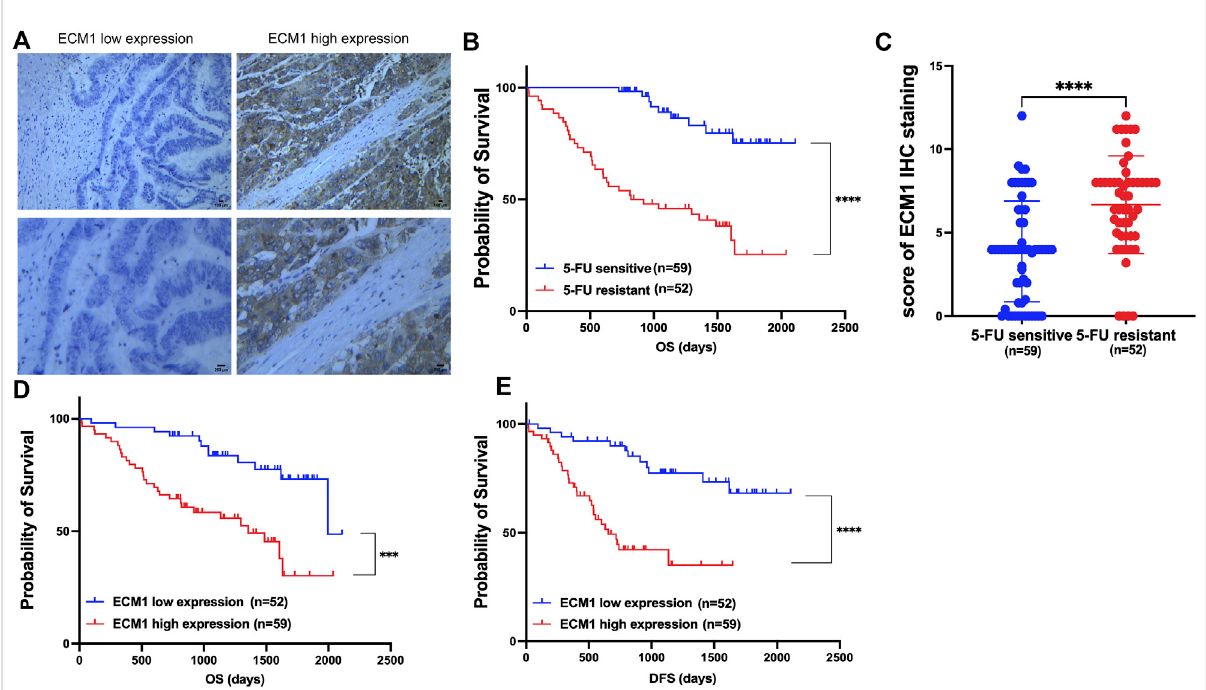
FIGURE 1 ECM1isassociatedwith5-FUresistanceandpoorprognosisinCRCpatients. (A) PhotographsillustratingthepresenceofECM1proteinintumor tissue samples from CRC patients. (B) Kaplan-Meier analyses of the OS of 5-FU-sensitive and -resistant patients. (C) The ECM1 expression of 5-FU- resistant and -sensitive patient samples was assessed. (D,E) The OS (D) and DFS (E) of patients expressing low and high levels of ECM1 were compared. Data are means ± SD (*** p < 0.001, **** p <